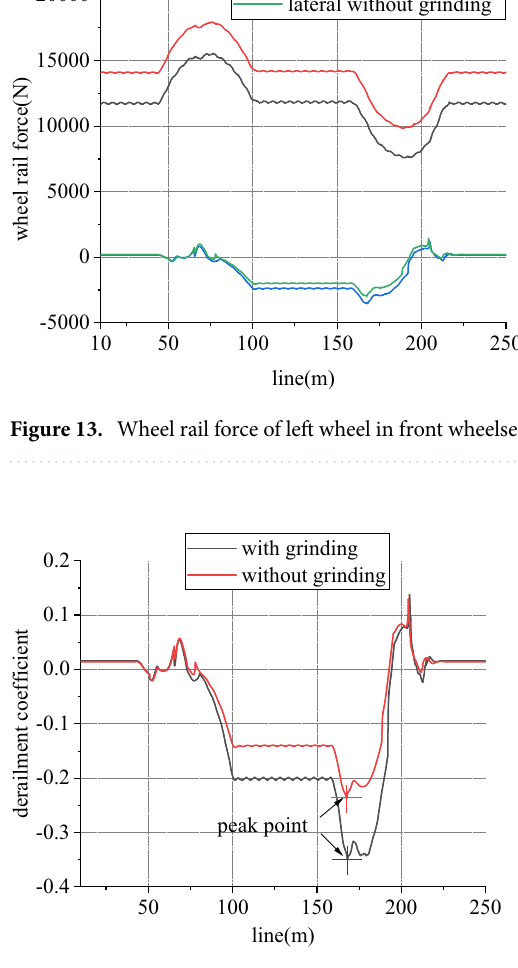
Figure 14. Derailment coefficient of left wheel in front wheelset (typical